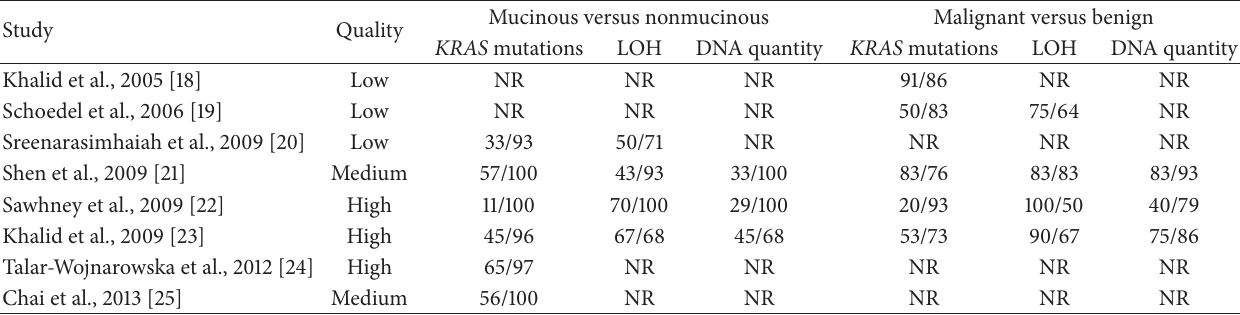
Table 2: Study quality and sensitivity/specificity for